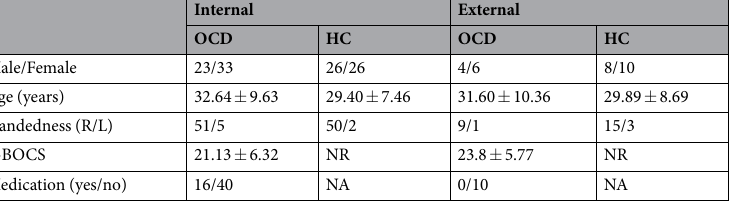
Table 1. Demographic information of the participants used to construct the classifier for the OCD and HC populations (mean ± standard deviation). All demographic distributions are matched between the OCD and HC populations in the internal and external datasets ( P > 0.05). NR, not recorded. NA, not